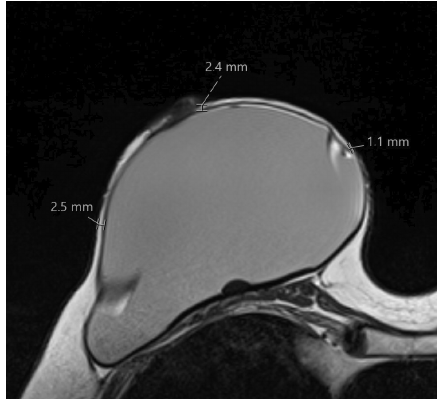
Figure 1. Frontal and craniocaudal schematic diagram of the breast with the measurement regions marked by time and red ellipse for the retromamillary measurement region. The lines in the left breast diagram are to represent the orientation in the MRI image.